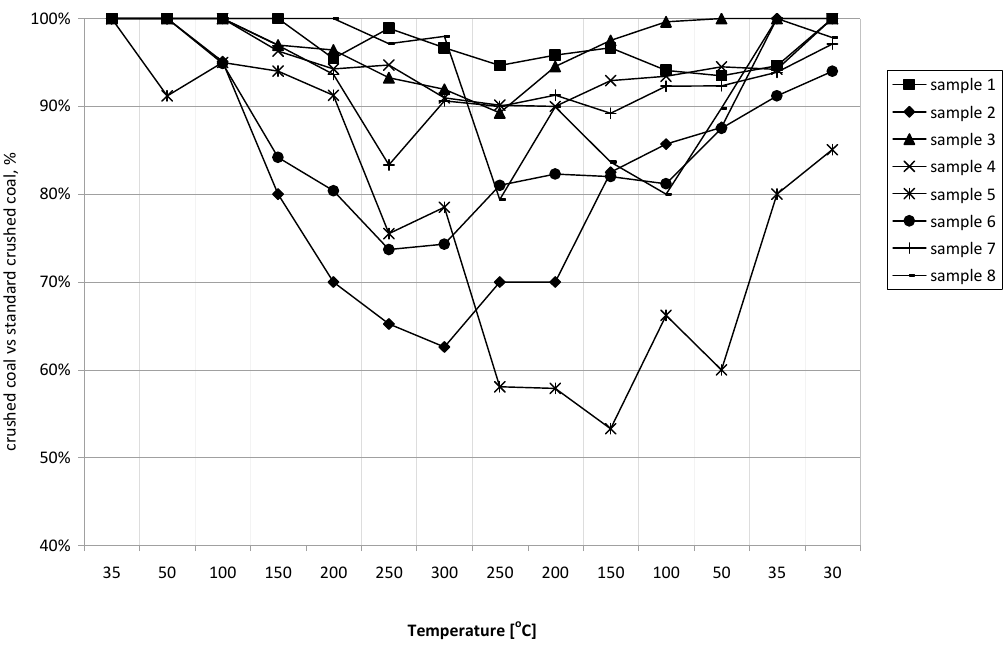
Figure 7. The course of changes in the ratio of released acetylene (for both coarse and standard crushing) in the stages of heating and cooling of coal samples.